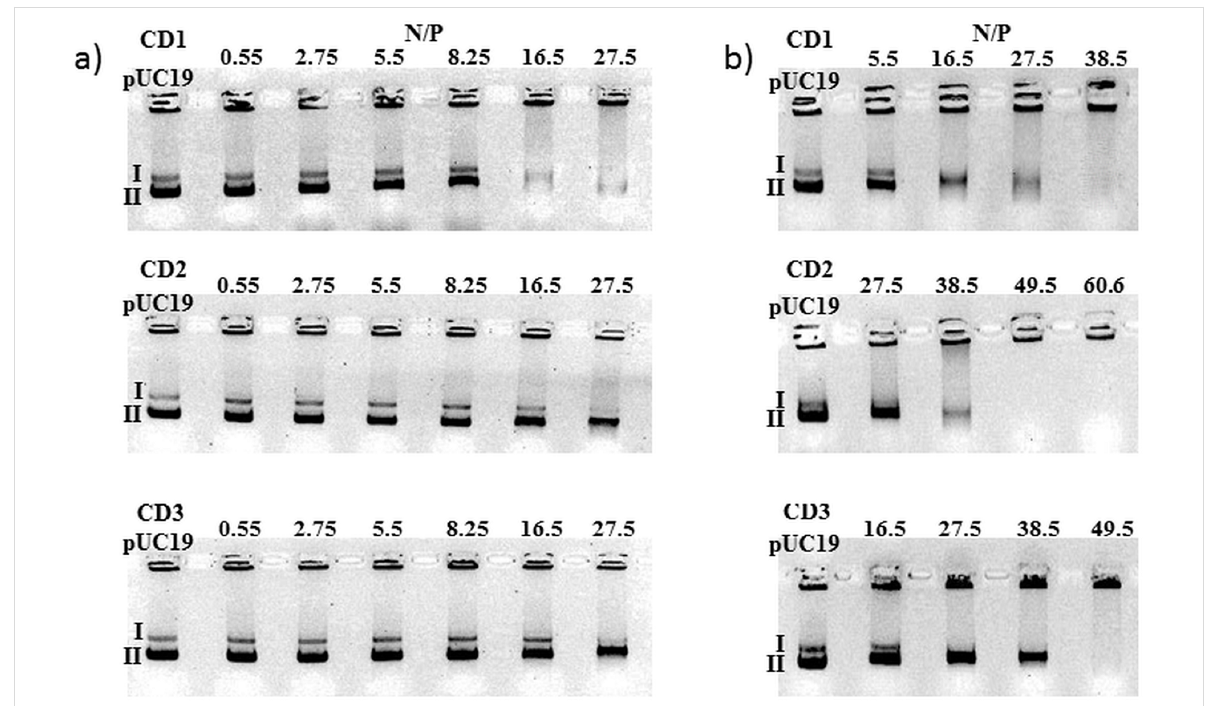
Figure 8: Electrophoretic mobility shift assays of pDNA in the presence of AmCDs at different N/P ratios, as indicated. I and II indicate the linear and supercoiled conformation of the pDNA, respectively. Binding is shown by the disappearance of one of the three bands: a) N/P ratios were between 0 (pUC19 only) and 27.5 for each AmCD; b) N/P ratios up to 38.5, 60.6 and 49.5 were used.